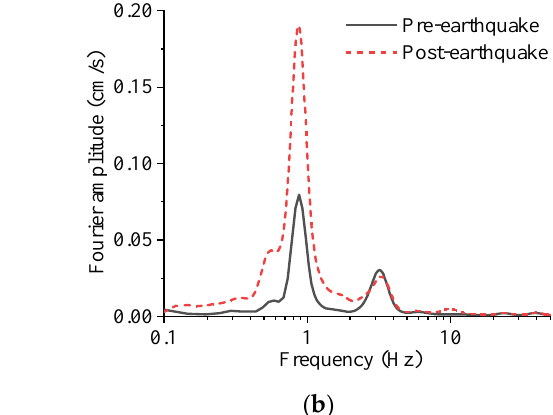
Figure 13. Fourier amplitude spectra in the NS and EW directions before and after the earthquake ( a ) NS; ( b ) EW.